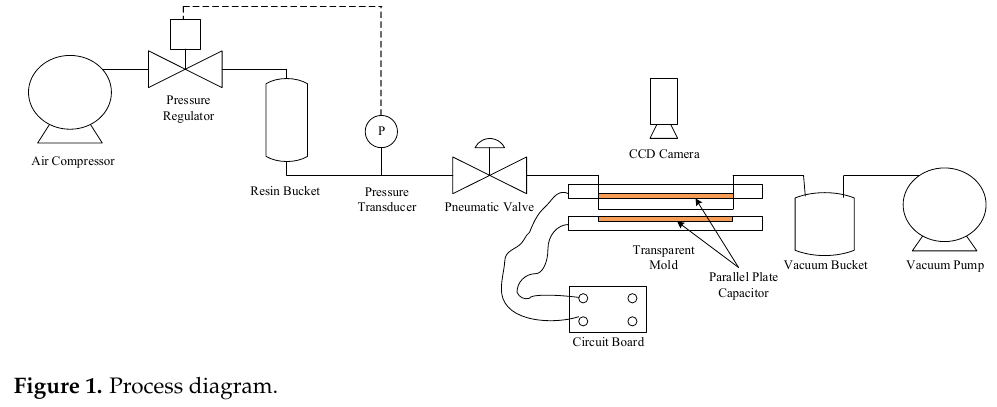
Figure 1. Process Figure 1. Process diagram.